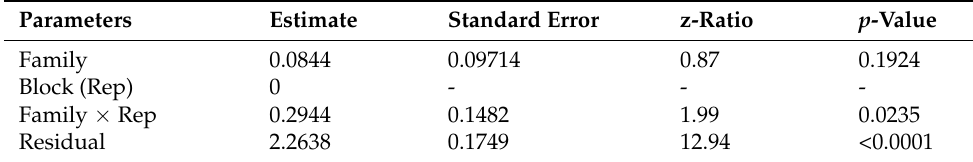
Table 3. Genetic variation in rust incidence in a Summer × Kanlow switchgrass population evaluated as half-sib families in the second generation in the greenhouse, 11 days after inoculation in